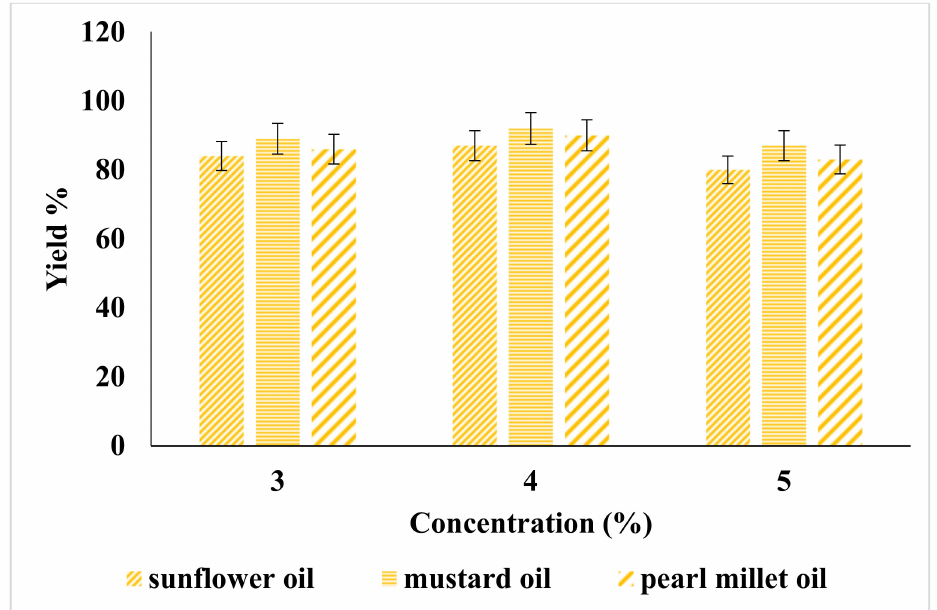
Figure 4. Percentage yield of biodiesel using lipase (%) as enzymatic